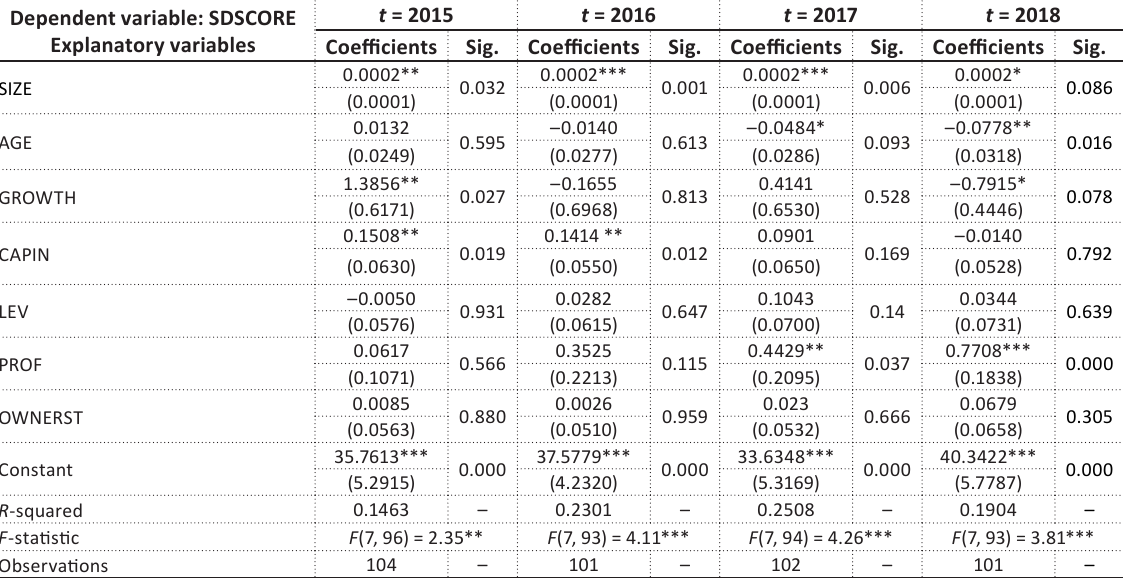
Table 5. Robustness check 1: regression models by year